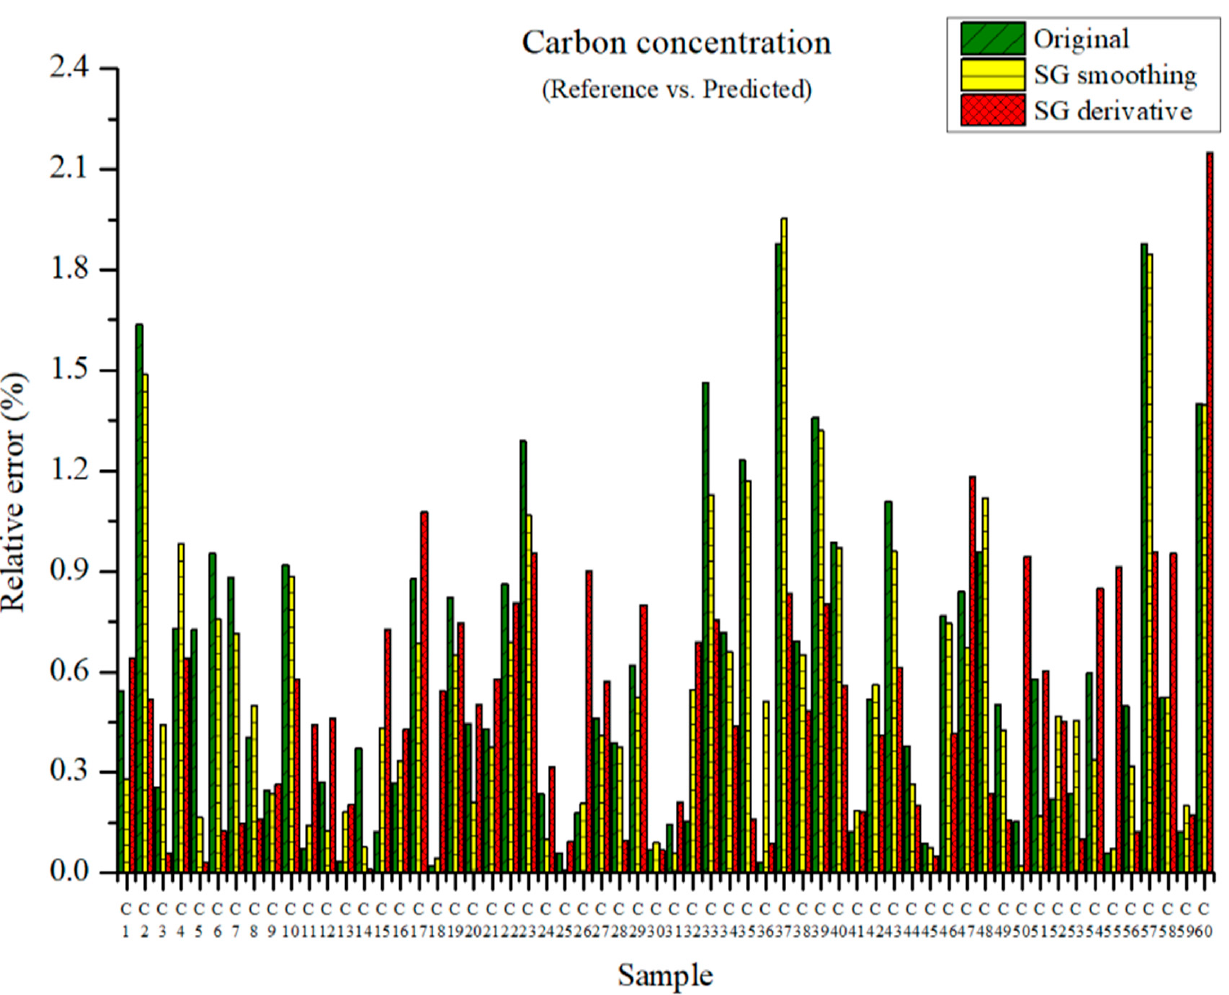
Figure 6. Comparison of relative errors between measured and predicted carbon concentrations for the PLSR models using the original data and pre-processed data. Figure 7b–d depict the PLSR models pre-processed by SG smoothing using first-order polynomials with one, three, and five smoothing points, respectively. In Figure 7a, the R 2 of calibration, the R 2 of cross-validation, the RMSEC, and the RMSECV are 0.90566, 0.77827, 0.04369, and 0.06812, respectively. As shown in Figure 7b, the R 2 of calibration, the R 2 of cross-validation, the RMSEC, and the RMSECV are 0.90977, 0.76406, 0.04273, and 0.07027, respectively. The PLSR model pre-processed by SG smoothing utilizing the first-order polynomial with three smoothing points is shown in Figure 7c. The R 2 of calibration, the R 2 of cross-validation, the RMSEC, and the RMSECV are 0.88495, 0.75905, 0.04825, and 0.07101, respectively. In Figure 7d, the R 2 of calibration, the R 2 of cross-validation, the RMSEC, and the RMSECV are 0.86682, 0.75215, 0.05192, and 0.07202, respectively. This shows that the adoption of many smoothing points does not guarantee more accurate or closer